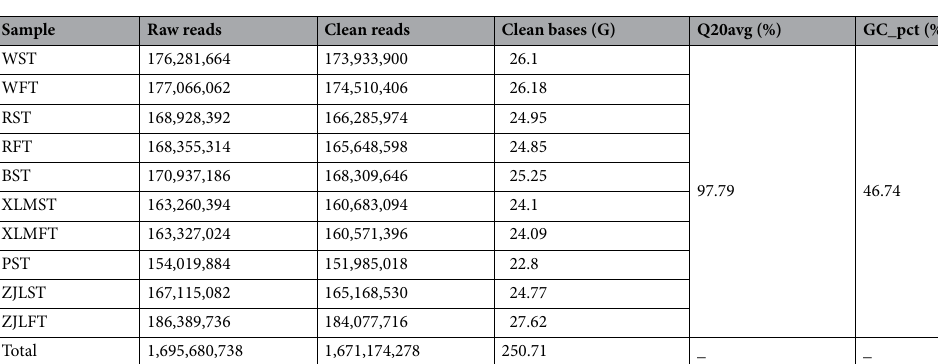
Table 1. Details of the raw data and clean data of all radish samples of various colors. WST transcript data of SZB with white taproot skin, WST transcript data of SZB with white flesh, RST transcript data of TXH with dark red taproot skin, RFT transcript data of TXH with dark red flesh, BST transcript data of black radish, XLMST transcript data of Xinlimei with green taproot skin, XLMFT transcript data of Xinlimei with red taproot flesh, PST transcript data of MSH with light-red taproot skin, ZJLST transcript data of ZJL taproot skin, ZJLFT transcript data of ZJL taproot